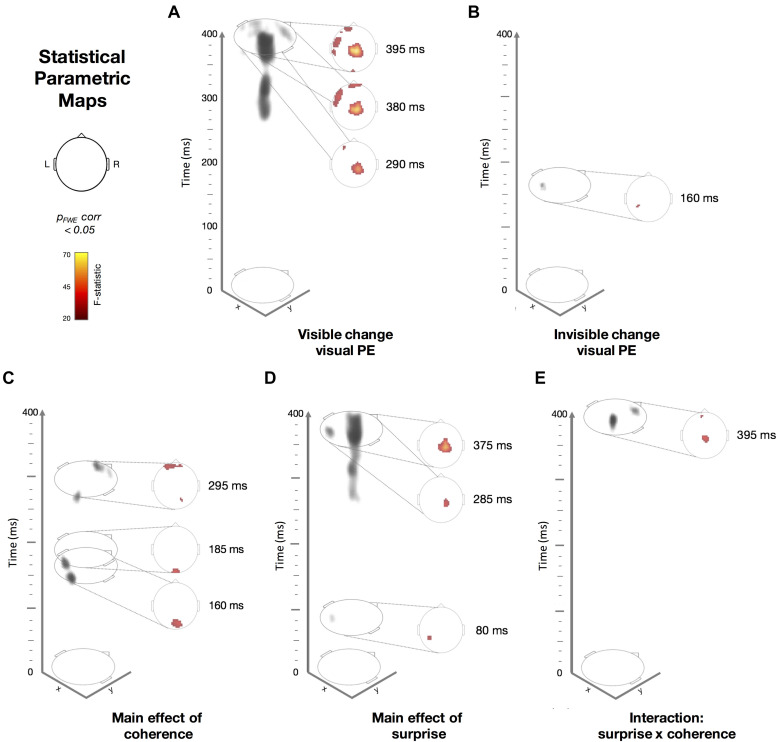
Spatiotemporal Statistical Parametric Maps showing thresholded F-statistic contrasts from the ERP data from (N = 19; pFWE corrected < 0.05). Scalp-topography orientation with respect to x- and y- axis is shown as a reference. The colormap indicates the range of F-statistic values used in (A–E), ranging from 20 (black) to 70 (yellow), where F = 24.18 corresponds to p < 0.05 with family-wise error (FWE) correction. On the left side of each panel, we show the 3D representation (gray shading) of the significant clusters across space (x, y) and time (z, from 0 to 400 ms after the trial onset). On the right side of each panel, we show a time slice (e.g., Z = 395 ms, for example) of the F-statistics. Dotted lines connect the time slice with its location within the 3D volume. (A) Visible standards versus (vs.) deviants. (B) Invisible standards versus (vs.) deviants. (C) The main effect of coherence (high vs. low; regardless of surprise). (D) The main effect of surprise (standards vs. deviants; regardless of coherence). (E) An interaction between coherence and surprise.